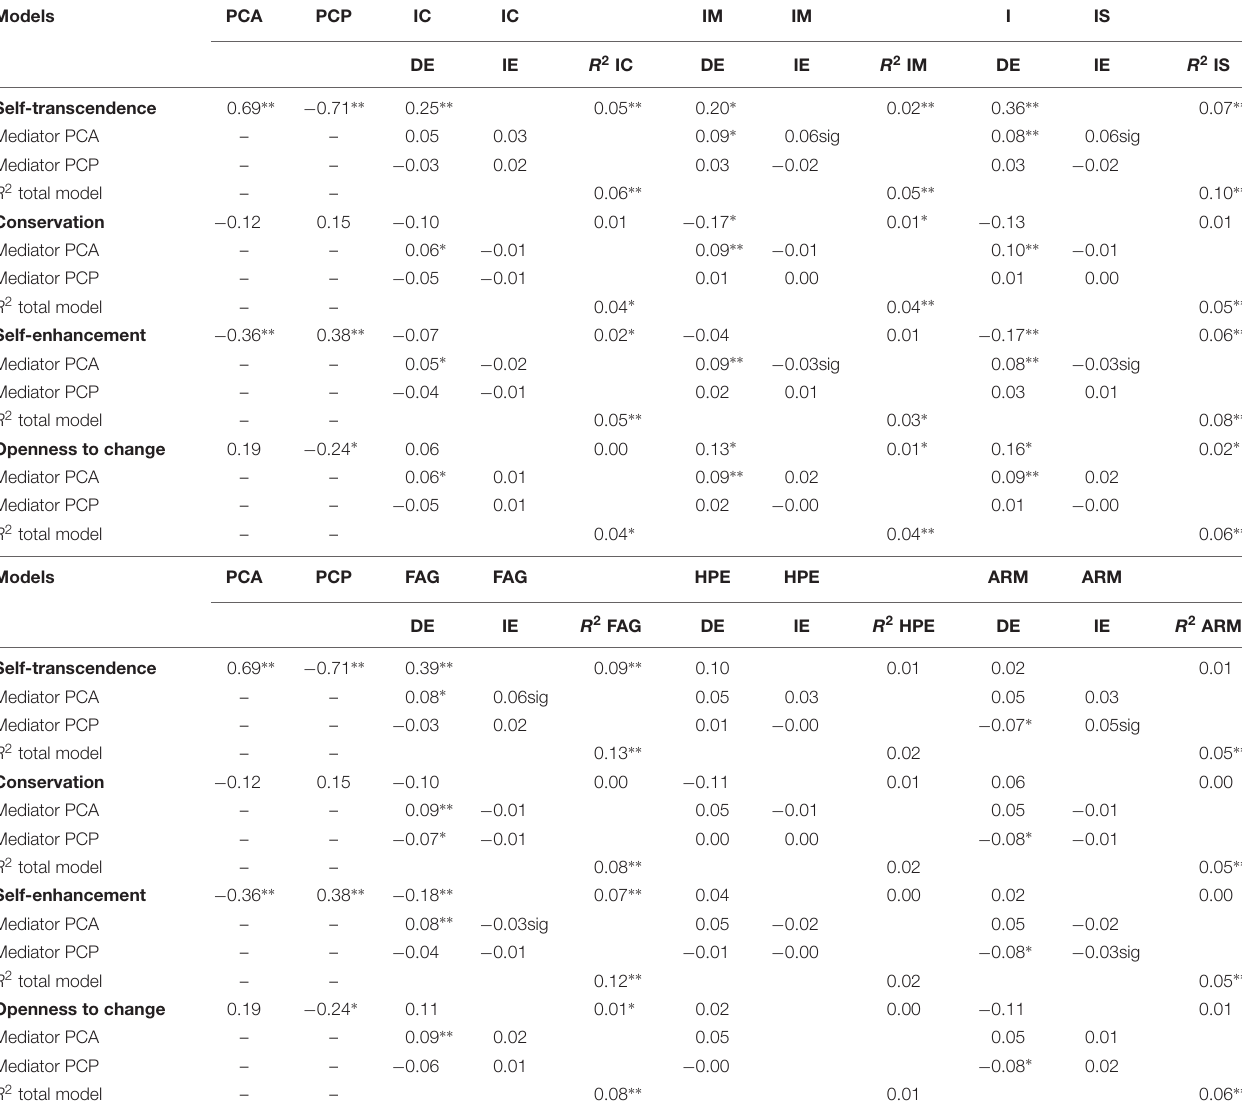
TABLE 7 | Results testing the mediation effects of perceived club autonomy and perceived club pressure between value dimensions and transformational leadership behaviors ( N = 266 coaches).